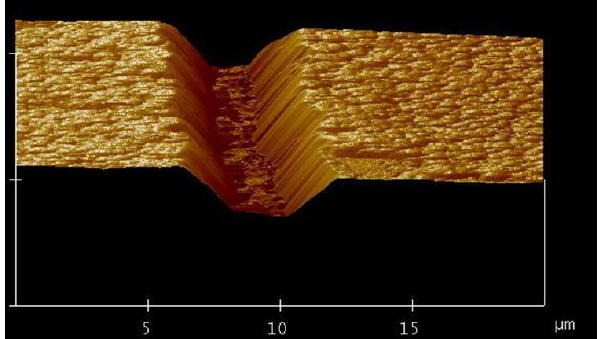
Figure 4. A femtosecond-laser-microfabricated microchannel in fused silica observed by atomic force microscope (AFM).